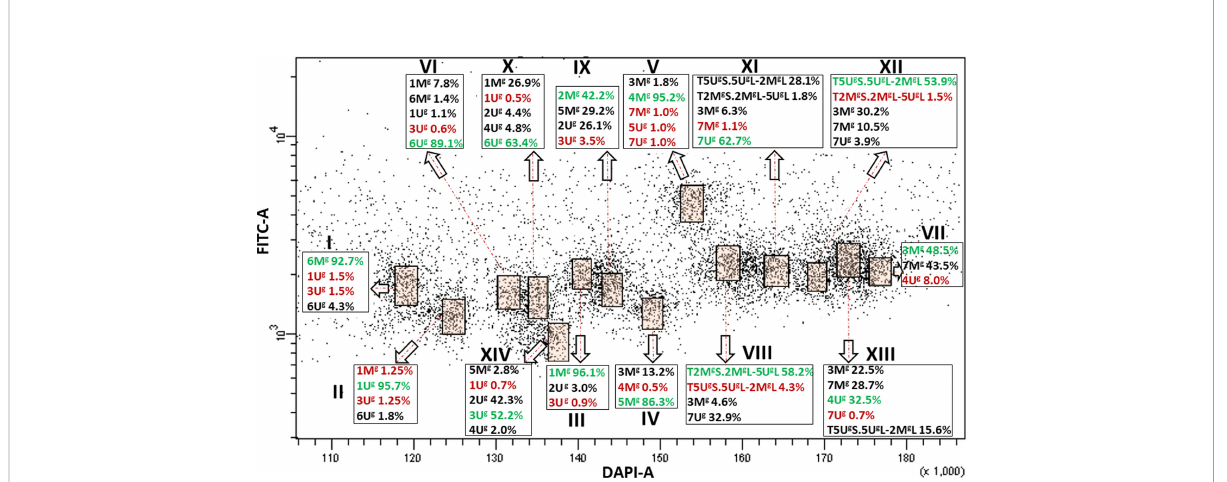
FIGURE 4 Bivariate fl ow karyotype (DAPI-A vs. FITC-A) obtained after FISHIS with the GAA 7 probe on chromosomes isolated from Ae. geniculata acc. AE660/83. The analysis permitted discrimination of fourteen chromosome populations (orange boxes) representing the whole genome of the species. The red and green numbers within a group of chromosomes sorted together refer to the lowest and highest purities, respectively. x- axis, relative DAPI fl uorescence; y-axis, relative GAA 7 -FITC fl